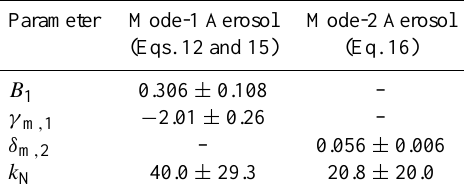
Table 2. Adsorption parameters calculated from aerosol character- istics reported by Keene et al. (2007) and Facchini et al. (2008) and the corresponding mean chl- a concentrations measured in seawa- ter. Combined uncertainties are reported. Dashes indicate that a parameter is not applicable for an aerosol mode. Parameter Mode-1 Aerosol Mode-2 Aerosol (Eqs. 12 and 15) (Eq. 16) B 1 0.306 ± 0.108 – γ m , 1 − 2.01 ± 0.26 – δ m , 2 – 0.056 ± 0.006 k N 40.0 ± 29.3 20.8 ± 20.0